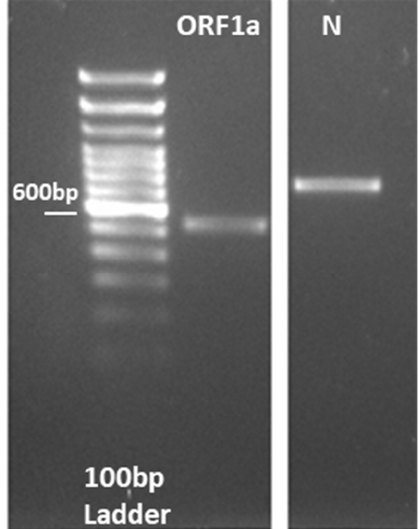
Figure 6. RNA synthesis by in vitro transcription, showing the gel electrophoresis for the PCR performed on ORF1a and N fragments where the T7 promoter sequence was added to the DNA fragment.